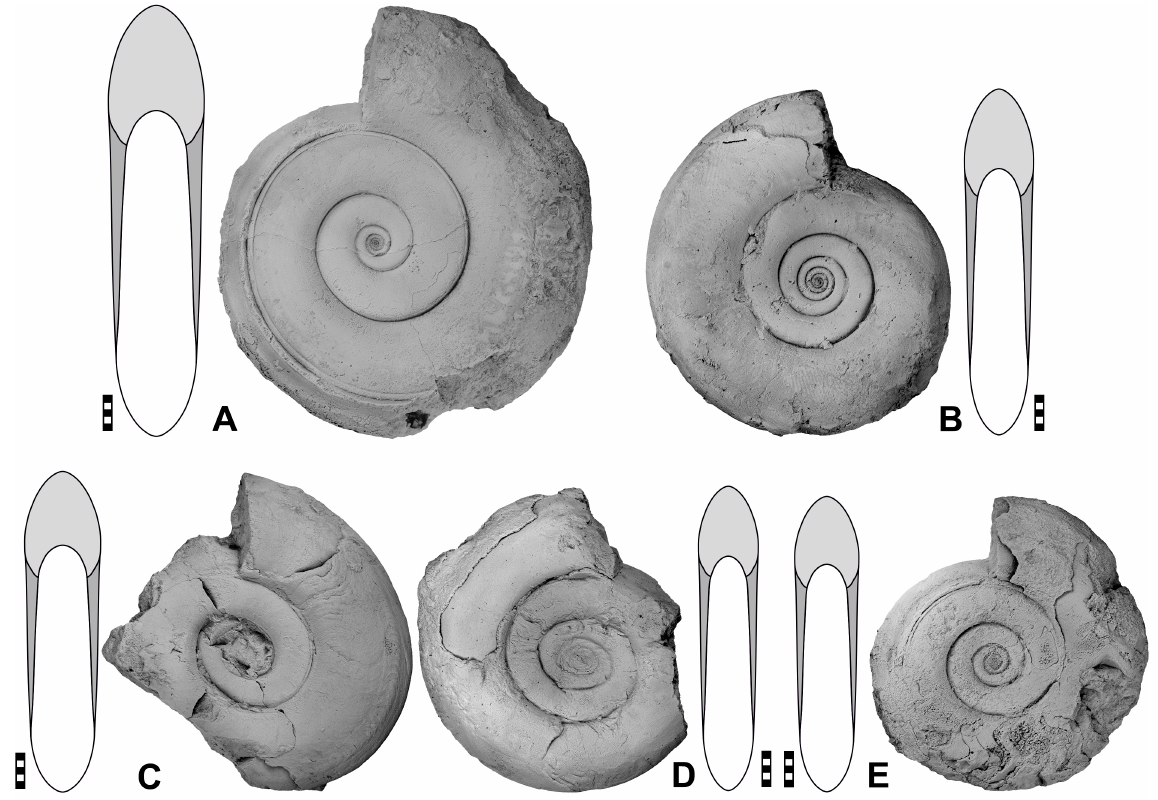
Fig. 8. Ponticeras aequabile (Beyrich, 1837). A . Specimen MB.C.4291 (Koch Coll.) from